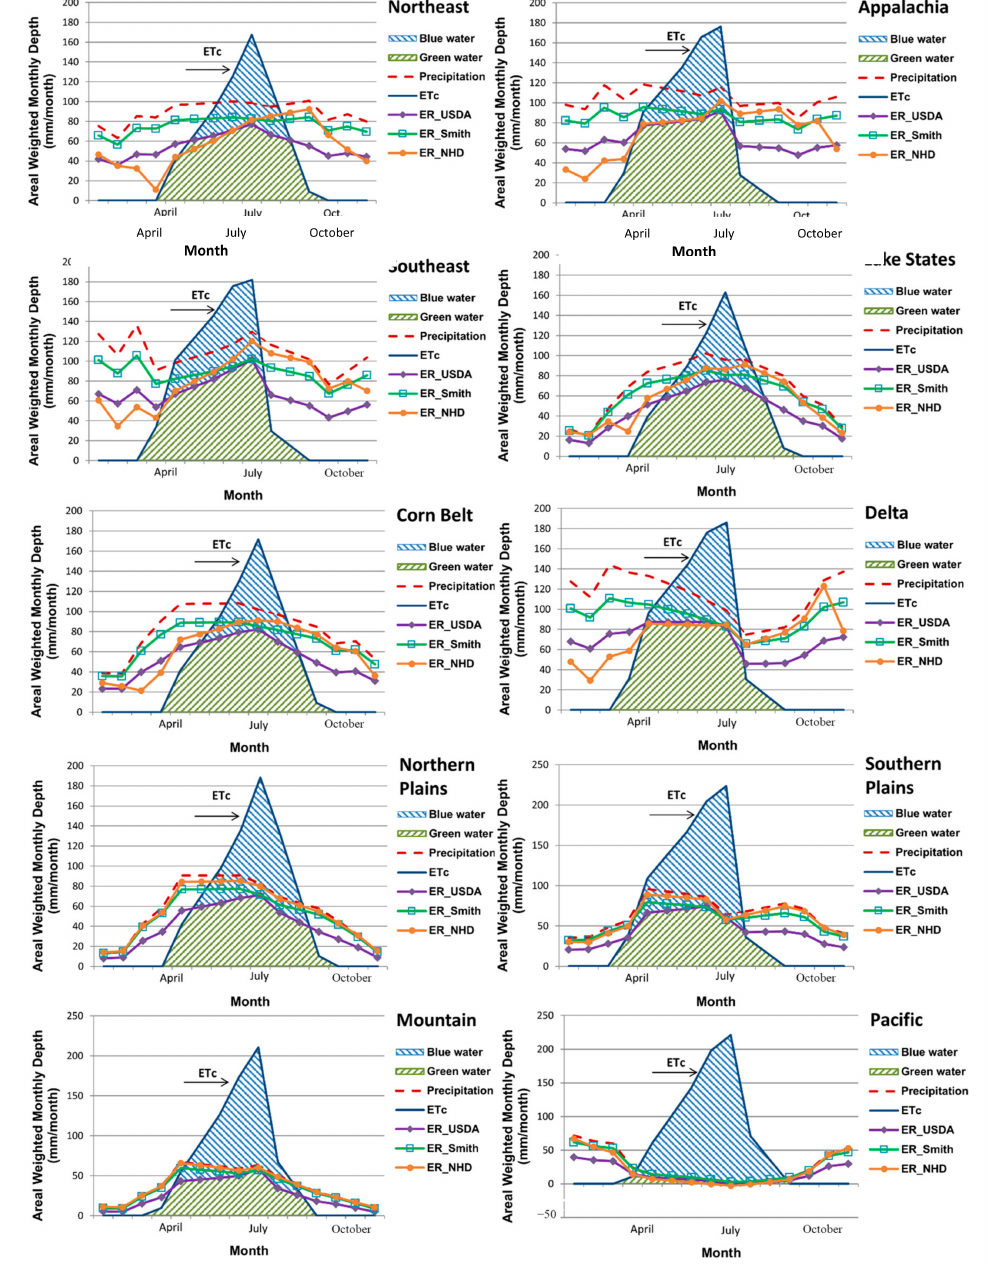
Figure 5. Comparison of monthly precipitation, corn evapotranspiration (ETc of corn), and green water resources (calculated from effective rain) based on three methods (Smith, USDA-SCS, and NHDPlus V2) for 10 major agricultural regions. Green water represents corn green water consumption and was calculated as the minimum of monthly green water resources and corn ETc. In a given month, if green water resource is lower than corn water demand (ETc), blue water represents the amount of irrigation water needed to make up the